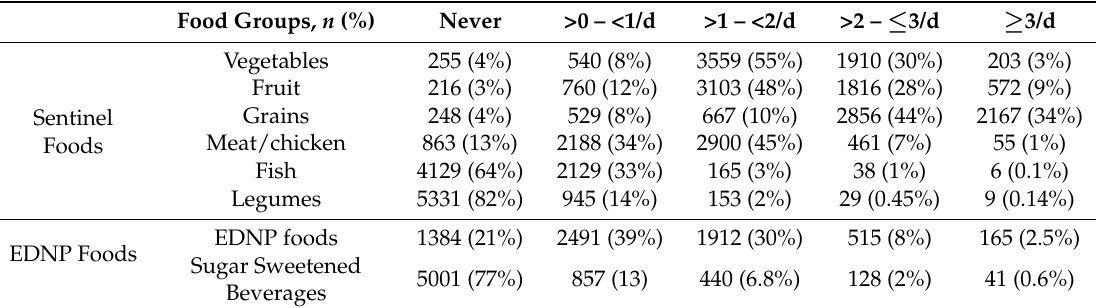
Table 4. Frequency of food group consumption at an age of 9 months for infants enrolled in the Growing Up in New Zealand study.